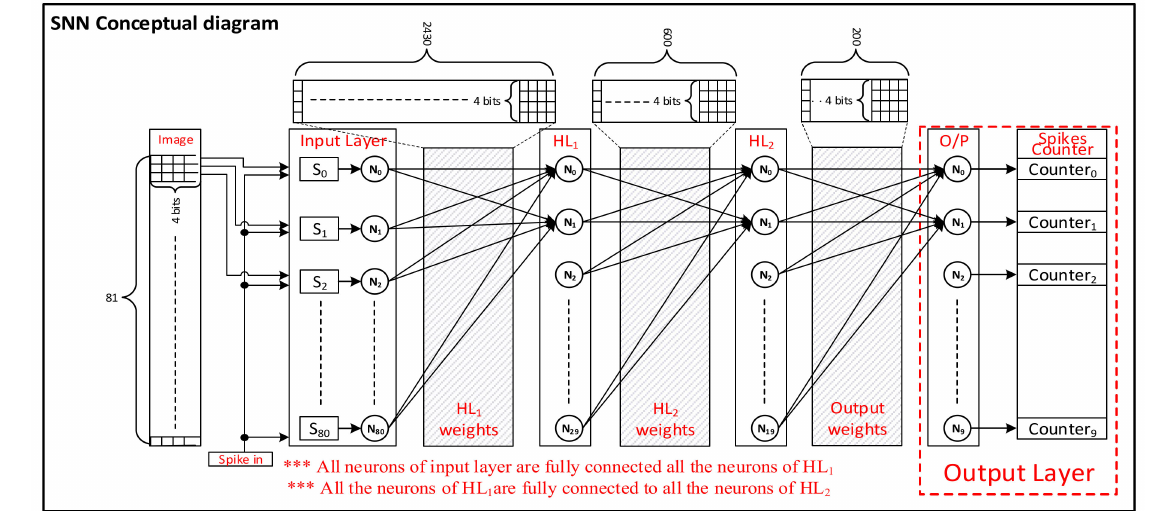
Figure 2. Block diagram of the SNN implementation consisting of four fully connected